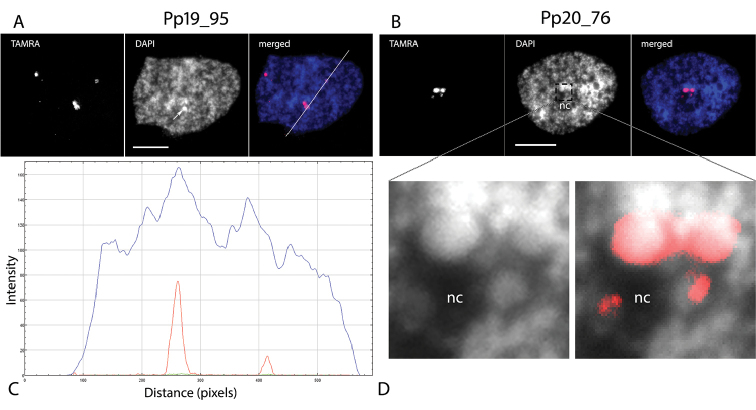
Nuclear organization of Pp19_95 (A, C) and Pp20_76 (B, D) TRs. A and B picture series shows fluorescence on DAPI and TAMRA channels and merged pictures C RGB profile of the nucleus; blue and red lines show the pixel intensity for two Pp19_95 FISH signals and DAPI staining, respectively D Digitally zoomed in part of the nucleus with red Pp20_76 FISH signals. nc marks the nucleolus. Scale bar: 5 µm.